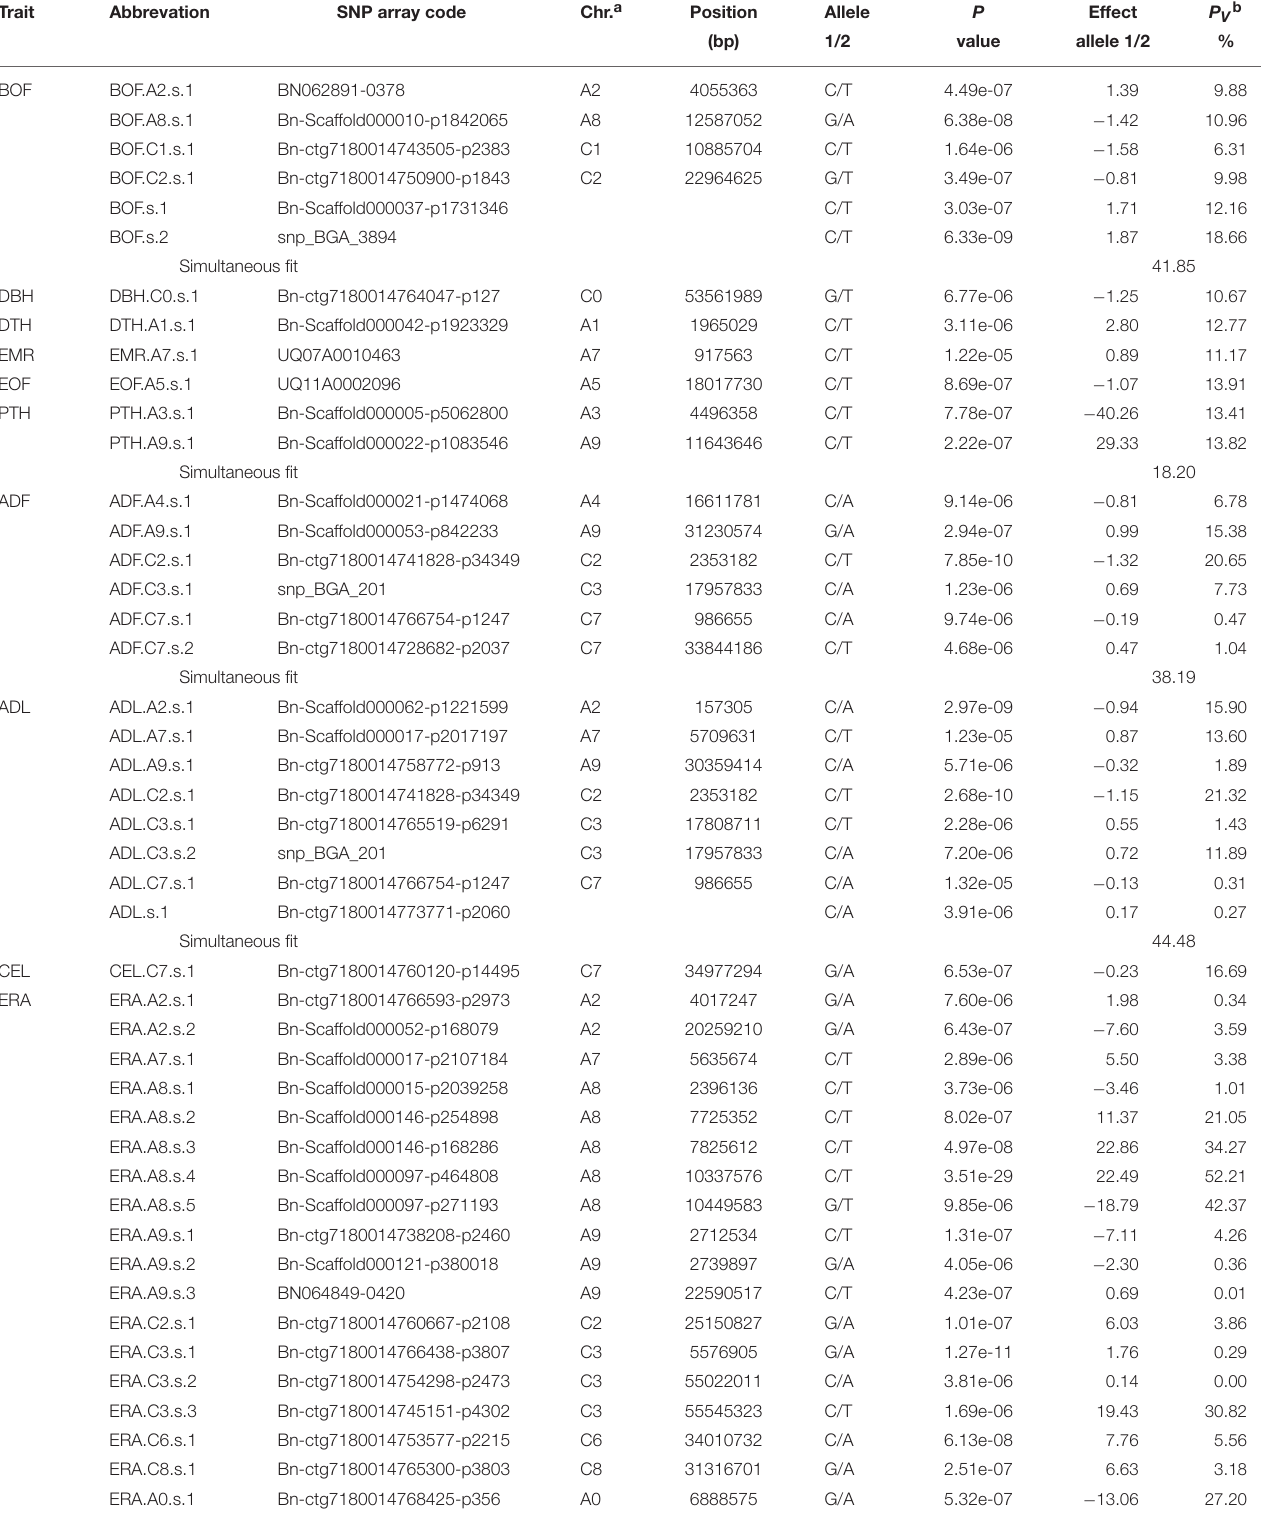
TABLE 2 | Single nucleotide polymorphism (SNP)-trait associations with P < 1.28e-05 (Bonferroni correction of α = 0.05) across the 184 inbreds of the spring trial.